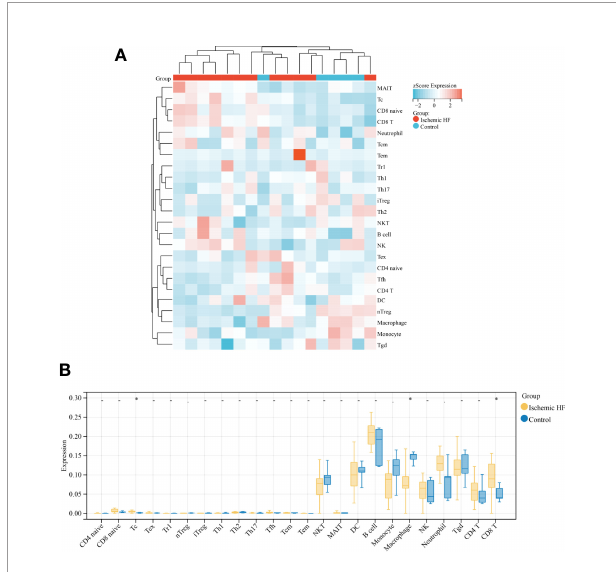
FIGURE 1 | Comparison of immune in fi ltration in HF and normal control samples (A) Heat map of immune in fi ltration between Ischemic HF and Control samples based on ssGSEA score analysis; (B) Comparison of immune cell in fi ltration in Ischemic HF and Control samples. * P <